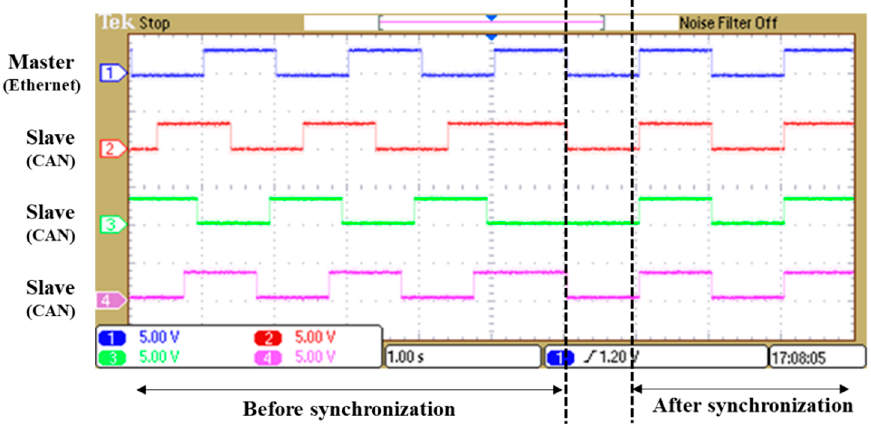
Figure 7. Comparison of the trigger signals before and after synchronization.